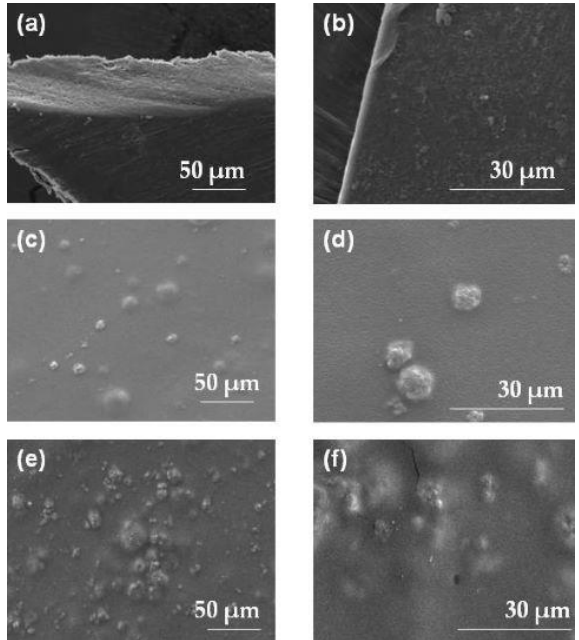
Figure 1. SEM picture of ODFs: placebo ODF under magnification ( a ) 2000× and 5000× ( b ); ODF with MP-S-RUP under magnification ( c ) 2000× and ( d ) 5000×; ODF with MP-A-RUP under magnification ( e ) 2000× and ( f ) 5000×.